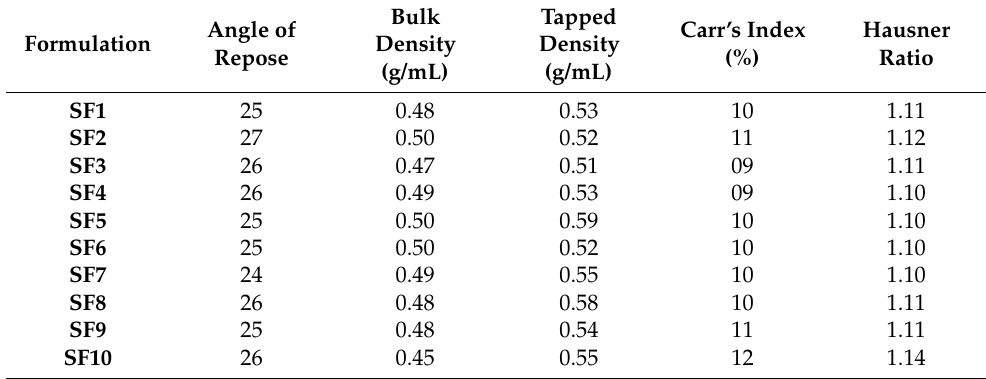
Table 1. Pre-compression parameters.